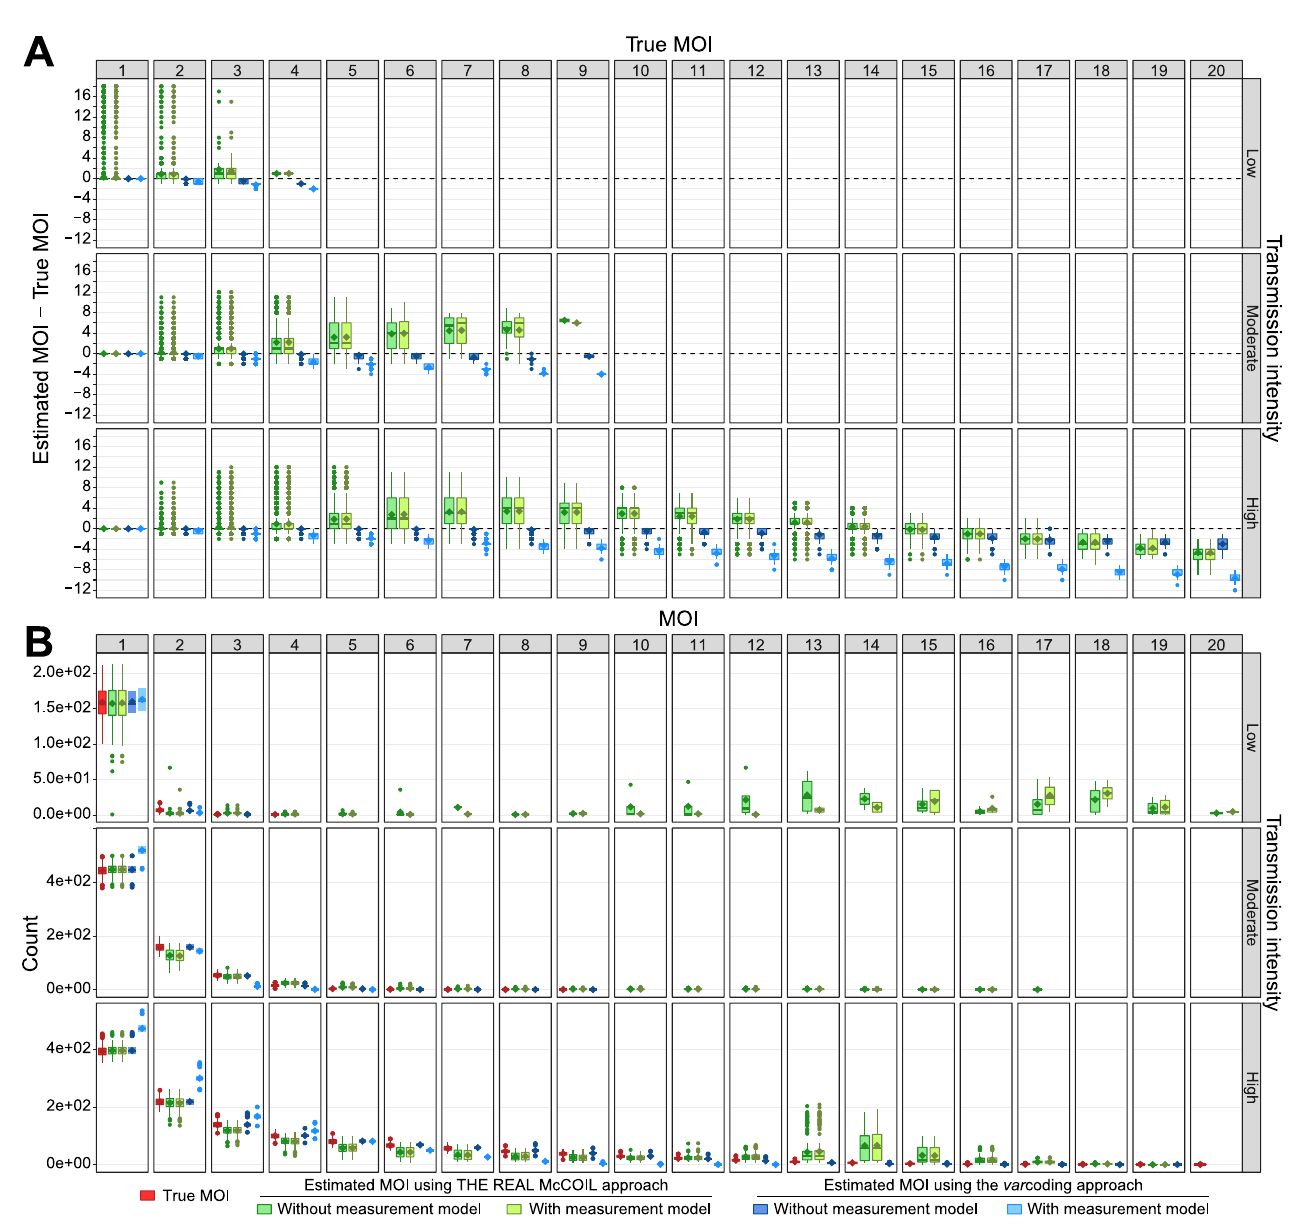
Fig 1. Multiplicity of infection (MOI). For each category, the horizontal central solid line represents the median, the diamond represents the mean, the box represents the interquartile range (IQR) from the 25th to 75th centiles, the whiskers indicate the most extreme data point, which is no more than 1.5 times the interquartile range from the box, and the dots show the outliers, i.e., the points beyond the whiskers. The upper, middle, and lower row panels show correspond to simulations under low-, moderate-, and high-transmission settings, respectively (S1 and S2 Tables). A) Accuracy of MOI estimates, defined as the difference between estimated and true MOI per host. While null values highlight accurate MOI estimates (indicated by a dashed black horizontal line), the positive and negative values highlight over- and under-estimation, respectively. Estimates with the neutral SNP-based approach (THE REAL McCOIL) are indicated in green, and those with the var gene-based approach ( var coding) are indicated in blue. The dark and light green or blue colors indicate respectively MOI estimations made without and with a measurement model (Fig 2). The column panels show differences for specific true MOI values. B) Population distribution of the estimated and true MOI per host from the simulated “true” values and those estimated with the methods indicated by the colors similar to panel A. For high transmission, the distribution obtained with THE REAL McCOIL shows a more pronounced tail than that from the simulated infections, with a secondary peak around MOI = 14. Note that the method considerably over-estimates individual MOI below that value but then under-estimates above it (panel A). Thus, these opposite trends compensate each other to some extent in the population distribution, producing nevertheless a deviation at high values. The var coding method provides a good representation of the “true” distribution from the simulations, and of the individual values in general, with a consistent tendency to underestimate when sampling error is taken into account.